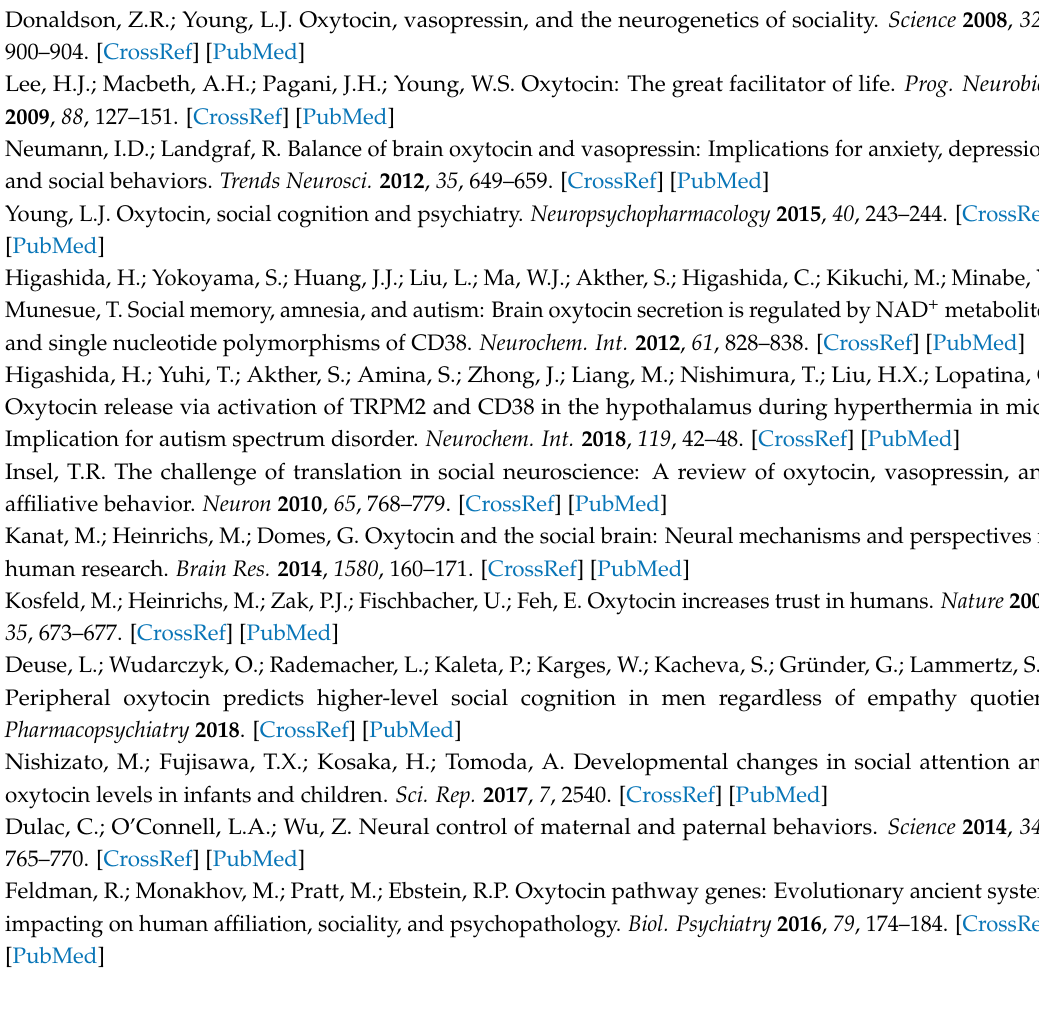
s1, Figure S1: Cooking in a group performed by students from the medical school and laboratory workers. Figure S2: Salivary OT levels in adult samples after intestinal delivery of different concentrations of